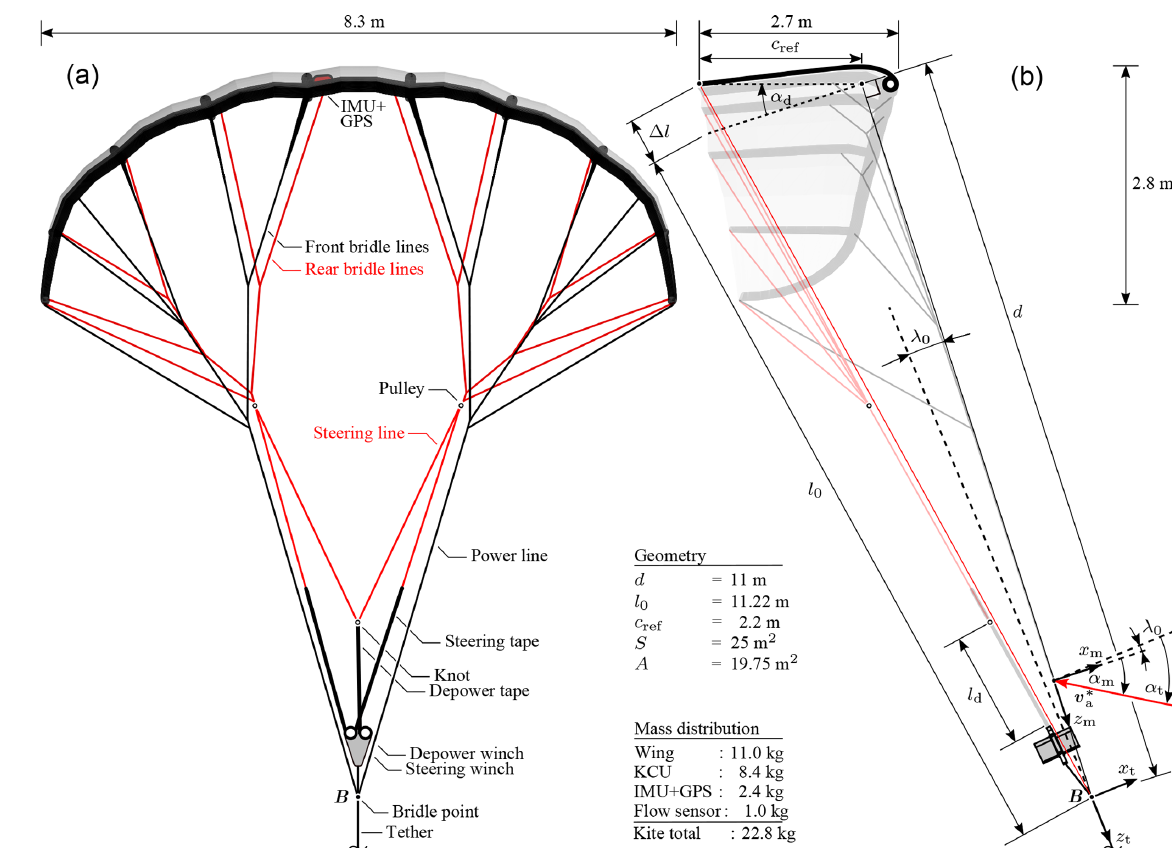
Figure 5. Front view ( a ) and side view ( b ) of the LEI V3 kite with reference frames, geometric parameters, mass distribution and definition of the reference chord c ref . The total wing surface area is denoted as S , while the projected value is denoted as A . The mass of the bridle lines is part of the wing mass. The side view distinguishes between the physical (real) kite and bridle line system, displayed in the background, and the overlaid simplified geometric depower model. The explicit dimensions describe the unloaded design shape of the